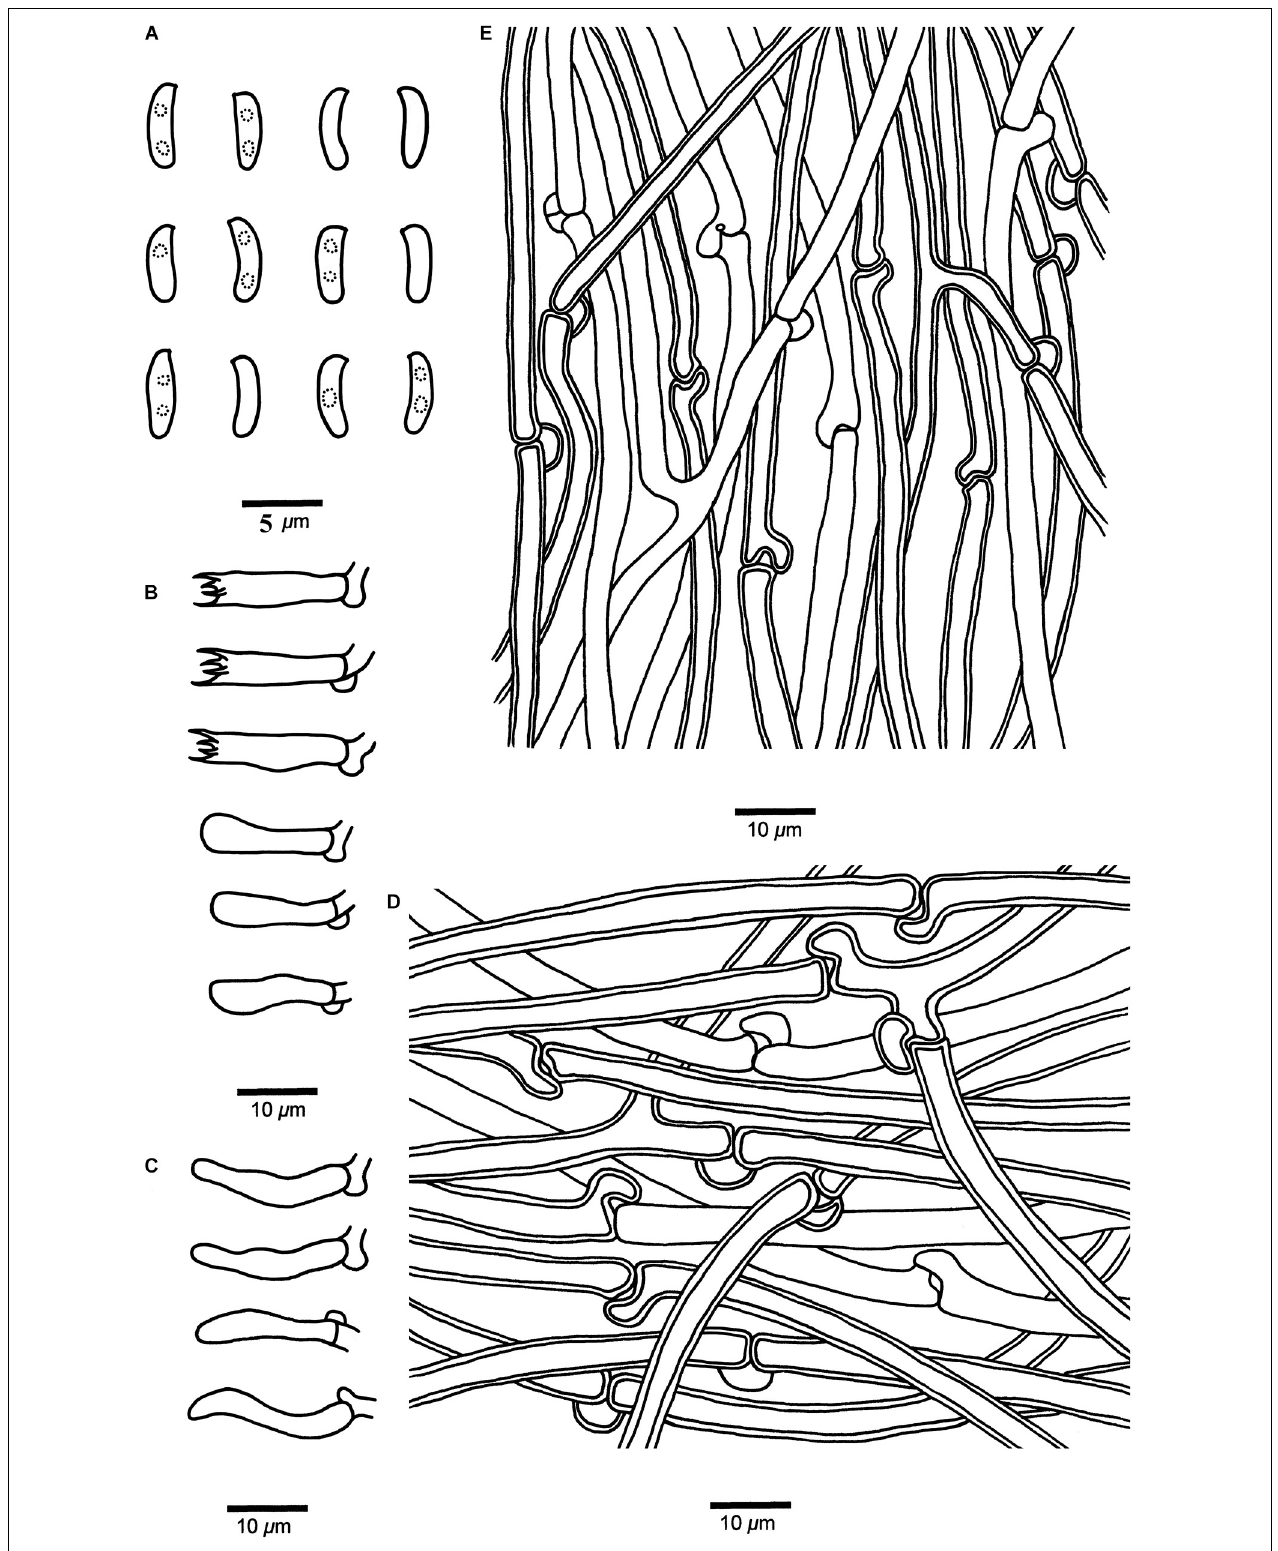
FIGURE 6 | Microscopic structures of Cyanosporus hirsutus (drawn from the holotype). (A) Basidiospores; (B) Basidia and basidioles; (C) Cystidioles; (D) Hyphae from trama; (E) Hyphae from context. Bars: (A) = 5 µ m; (B–E) = 10 µ m.